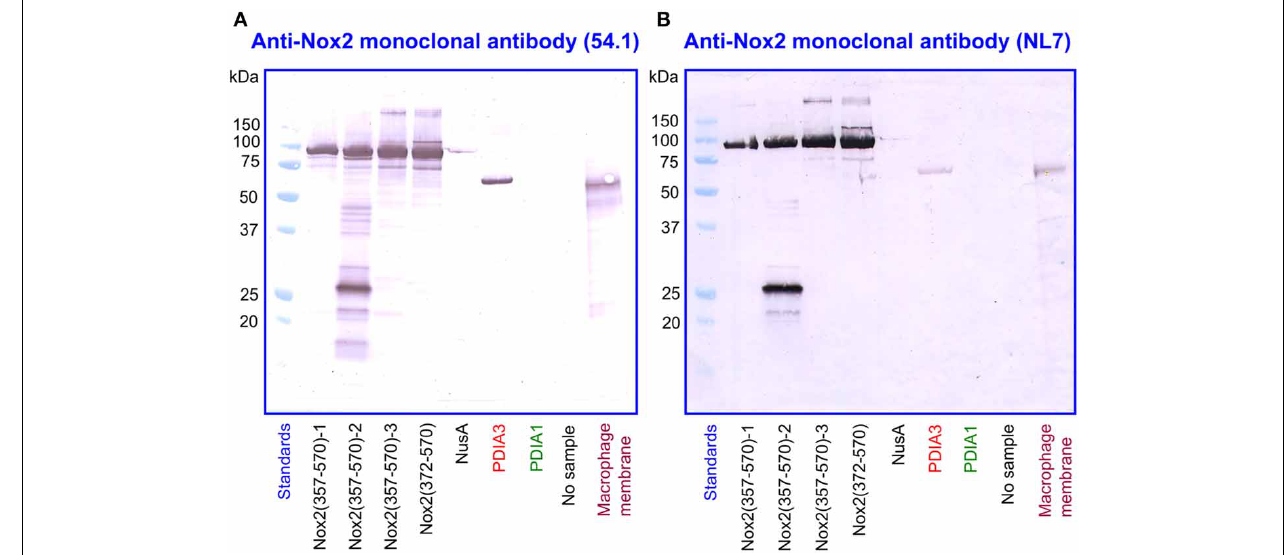
FIGURE 9 | Two monoclonal anti-Nox2 antibodies react with PDIA3 but not with PDIA1 by immunoblotting. (A) Monoclonal anti-Nox2 antibody 54.1 (epitope, residues 381–390) reacts with recombinant NusA-Nox2(357–570) and NusA-Nox2(372–570) but not with NusA. It reacts strongly with recombinant PDIA3 but not with recombinant PDIA1. It recognizes a protein of about 54–58kDa (diffuse band) in the guinea pig macrophage membrane, corresponding to Nox2 (Knoller et al., 1991). (B)